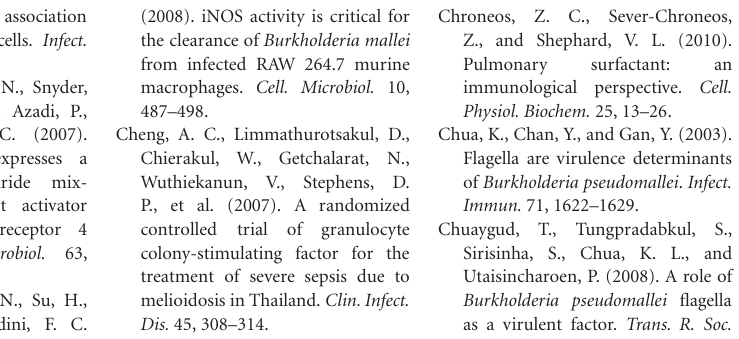
TLR agonists remained with the cells for an overnight incubation. The following day, samples were analyzed to determine luciferase activity. Data is expressed as relative luciferase activity. Both BM and BP (B) stimulated TLR4 as effectively as the LPS agonist (A) . However, the flagellin from BP stimulated TLR5 (B) as we detected flagellin in the medium of B-infected cells but not BM (C) . Three experiments were performed in using triplicate samples and data is represented as mean ± SEM and ∗ denotes significant differences of p < 0 .